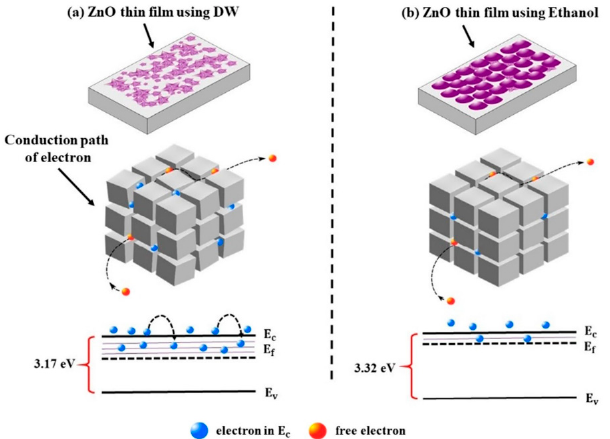
Figure 8. The conduction pathway of electrons (at grains and grain boundaries in the SILAR-depos- ited ZnO thin films using ( a ) distilled water, and ( b ) ethanol reproduced with permission from [135], Springer, 2022.